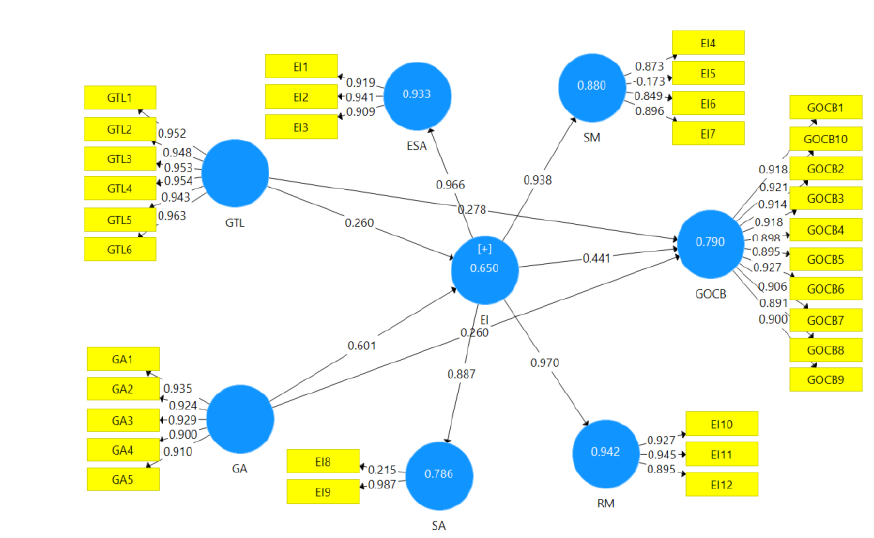
Figure 1: Outer model measurement results